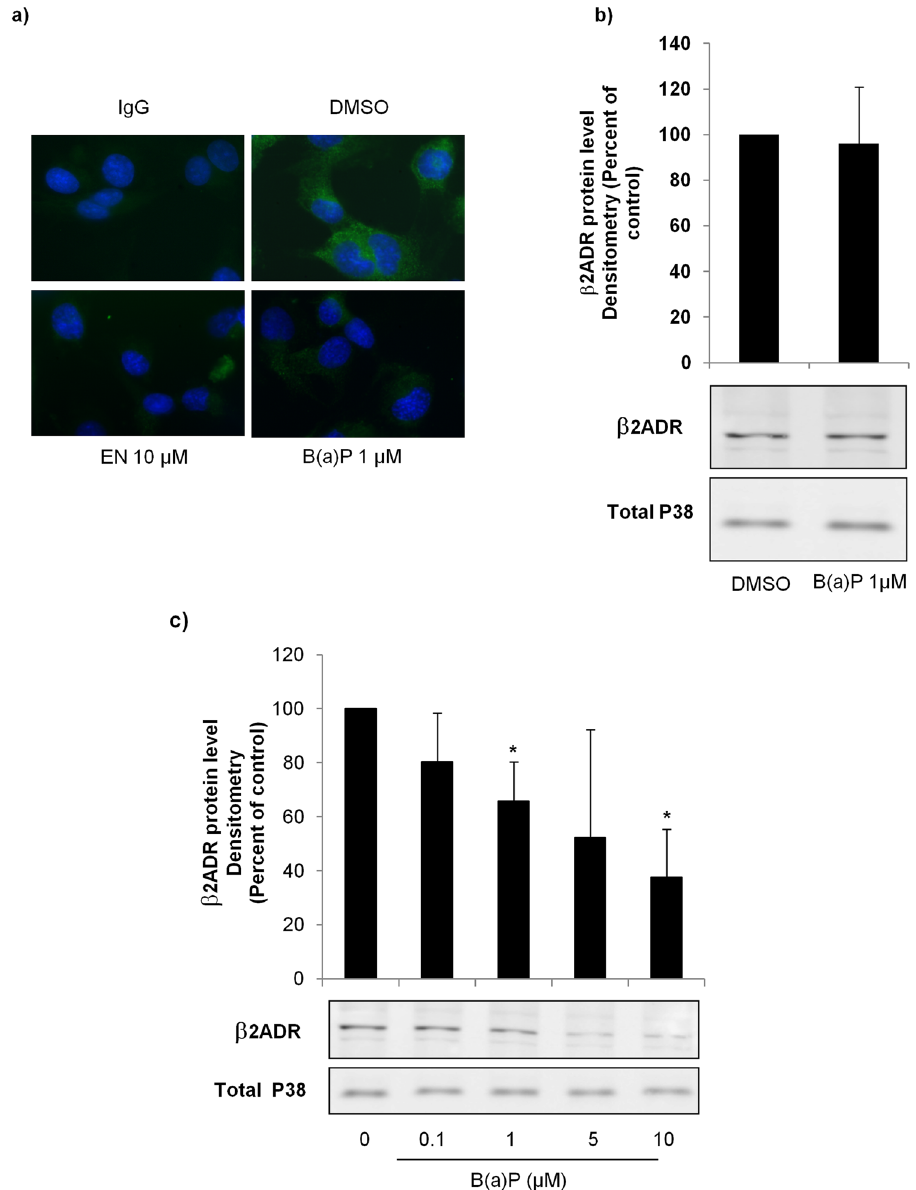
Figure 3. B(a)P triggered an early reduction of β 2ADR expression at cell membrane and a late degradation of β 2ADR protein. ( a ) HMEC-1 cells were exposed to 10 µ M EN, 1 µ M B(a)P or vehicle (DMSO) for 45 min. β 2ADR was then analyzed by immunolocalization for the expression at cell membrane. Data shown are representative of three independent assays. ( b ) HMEC-1 cells were exposed to 1 µ M B(a)P or vehicle (DMSO) for 45 min. β 2ADR protein content was then determined by Western-blotting. ( c ) HMEC-1 cells were exposed to indicated concentrations of B(a)P or vehicle (DMSO) for 24 h. β 2ADR protein content was then determined by Western-blotting. ( b and c ) Bottom panel, a representative blot is shown for β 2ADR and P38 protein levels. Upper panel, for each concentration of B(a)P, data were quantified by densitometric analysis, normalized to P38 protein level and expressed relative to β 2ADR found in untreated cells, arbitrarily set at the value of 100%. Results are the means ± S.D of values from three independent assays. * p < 0.05 when compared to untreated